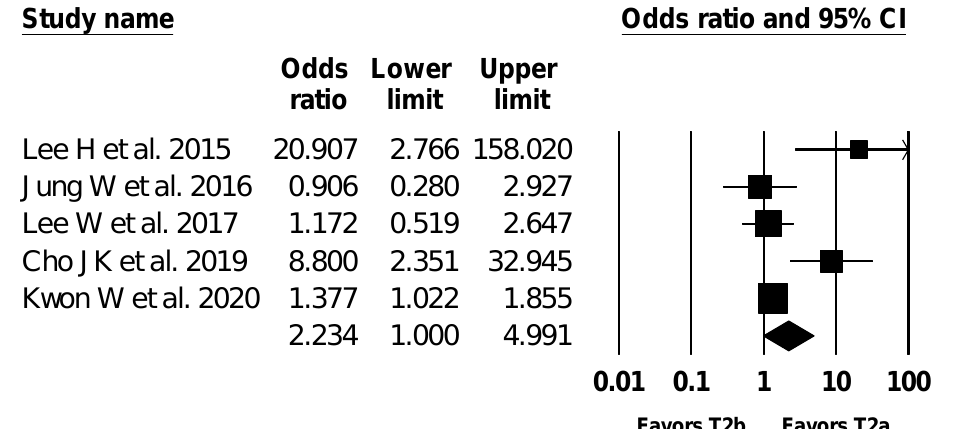
Figure 7. Forest plot of incidence of recurrence in T2a and T2b GBC patients. The figure depicts individual trials as filled squares with relative sample size and the 95% confidence interval (CI) of the difference as a solid line. The diamond shape indicates the pooled estimate and uncertainty for the combined effect.